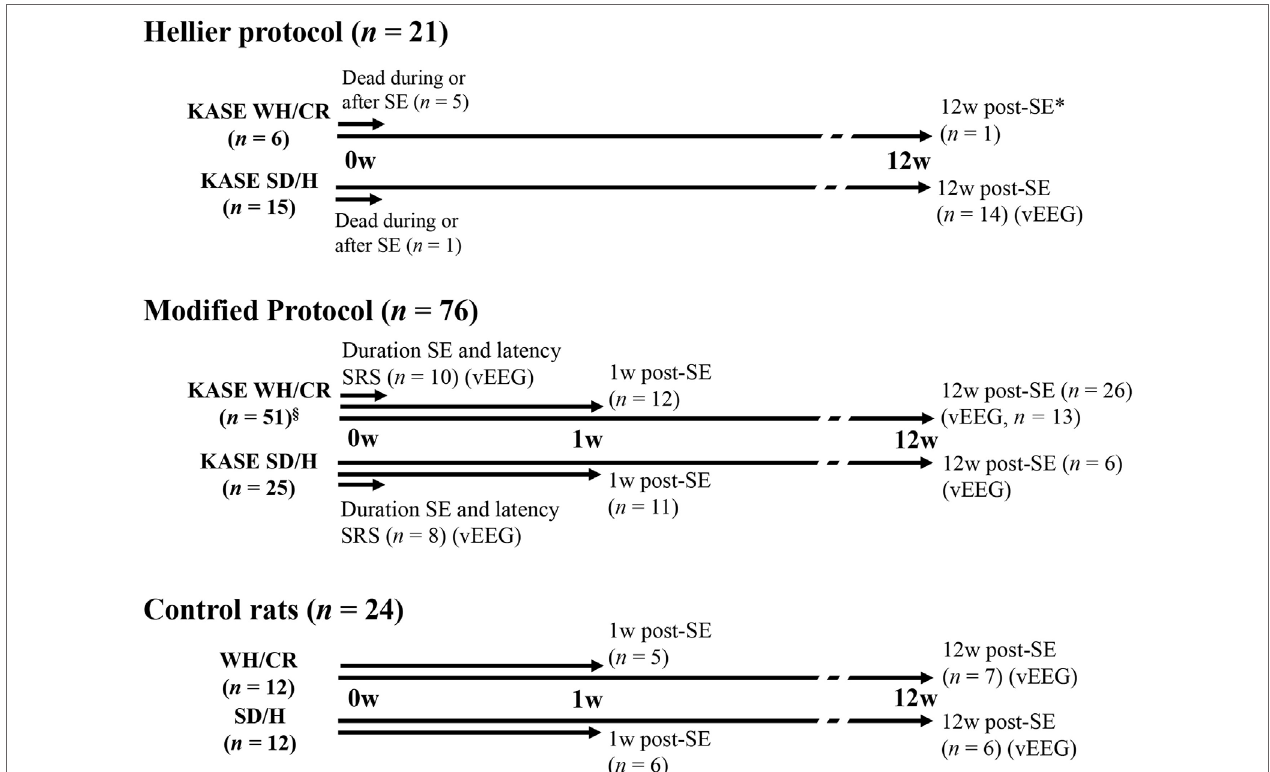
FigUre 1 | Schematic diagram illustrating the experimental design, the number of animals used for each SE induction protocol, and strain. Three animal groups were included in the study: a group of animals (duration SE and latency SRS) was vEEG monitored to determine the duration of SE and the latency to the first SRS (modified protocol: KASE WH/CR, n = 10; KASE SD/H, n = 8). A second group of animals (1 w post-SE) was sacrificed at subacute phase for postmortem analysis (modified protocol: KASE WH/CR, n = 12; KASE SD/H, n = 11; control rats: WH/CR, n = 5; SD/H, n = 6). Finally, a third group of animals (12 w post-SE) was vEEG monitored during chronic epilepsy and sacrificed for postmortem analysis (Hellier protocol: KASE SD/H, n = 14, only vEEG; modified protocol: KASE WH/CR, n = 26; SD/H, n = 6; control rats: WH/CR, n = 7; SD/H, n = 6). vEEG indicates animal that underwent vEEG monitoring. * was not included for further vEEG analysis or postmortem evaluation. § Three WH/CR died during SE. vEEG indicates animals underwent electrode implantation and were vEEG monitored. SE, status epilepticus ; w, weeks; KASE, kainic acid-induced status epilepticus ; WH/CR, Wistar Han/Charles River; SD/H, Sprague-Dawley/Harlan; n , number; vEEG, video-electroencephalography; SRS, spontaneous recurrent